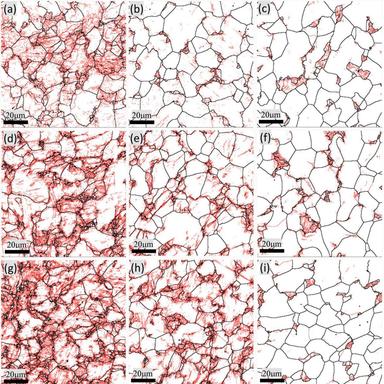
EBSD grain boundary images of 1440–600 sample after tensile deformation of (a–c) 2%, (d–f) 4%, (g–i) 6%. (a, d, g) r = 1.0 R, (b, e, h) r = 0.5 R, (c, f, i) r = 0 R. Black lines indicate misorientations >10◦, and red lines indicate misorientations >1◦. (For interpretation of the references to colour in this figure legend, the reader is referred to the Web version of this article.)